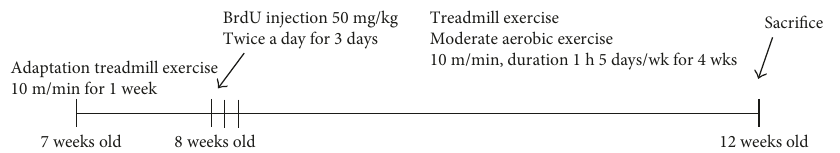
Figure 1: Experimental design of the present study. Treadmill exercise was adopted in 7-week-old mice for 1 week, and treadmill exercise was conducted for 4 weeks with 10m/min speed for 1 h. During the fi rst 3 days of exercise, BrdU was injected twice a day (at 8:00AM and 8:00PM) intraperitoneally to label newborn neural stem